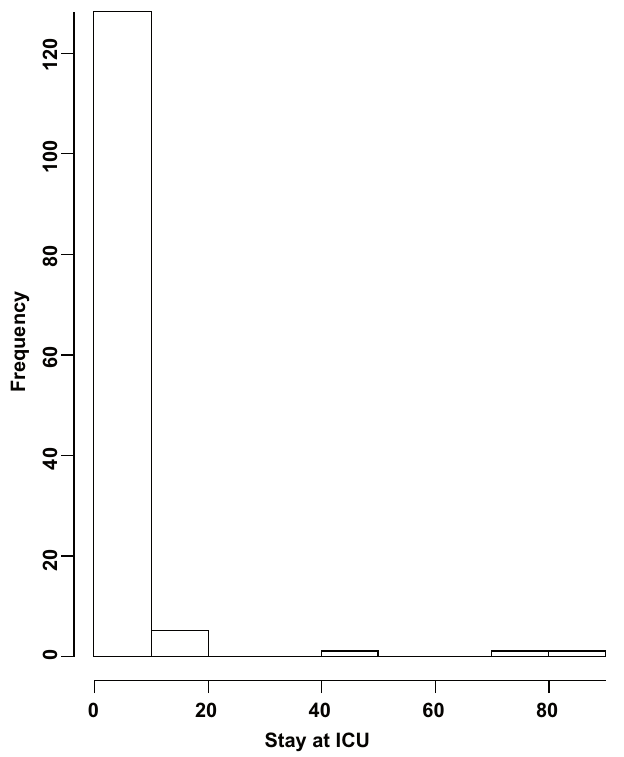
Figure 5. Distribution of stay at ICU (days). Histogram of frequencies of stay at ICU in the included patients.